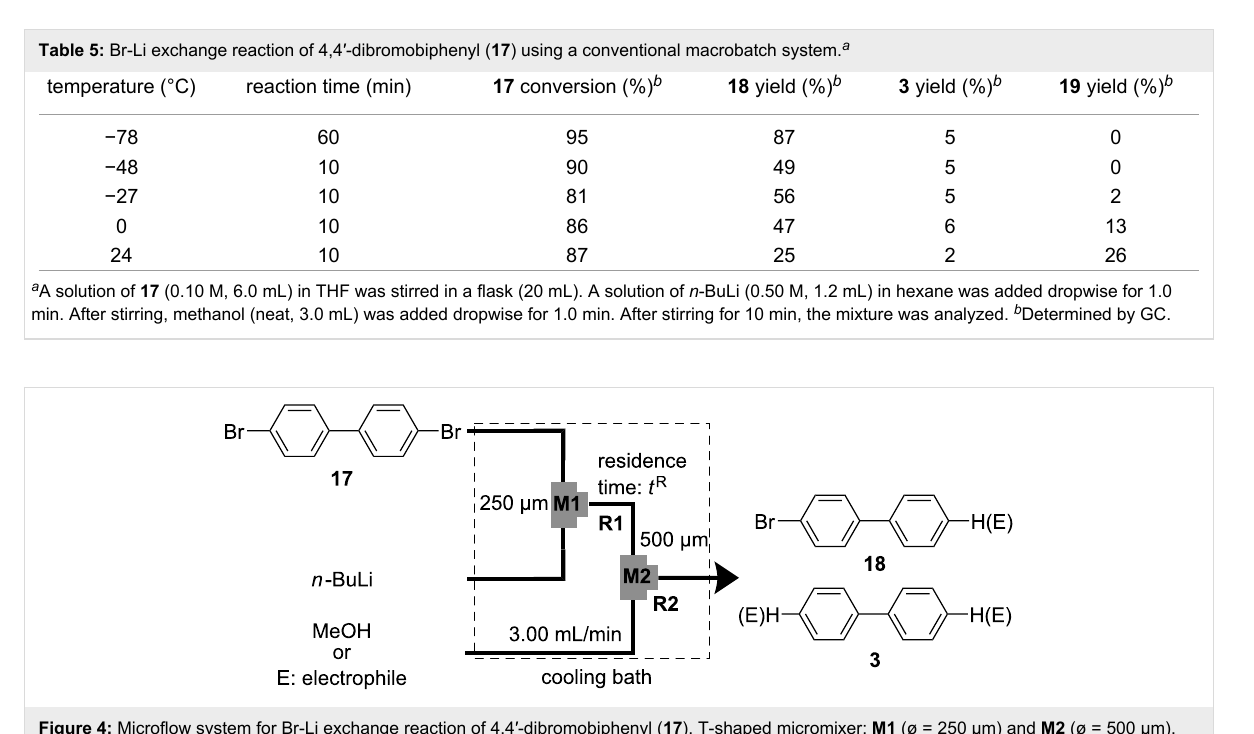
Figure 4: Microflow system for Br-Li exchange reaction of 4,4′-dibromobiphenyl ( 17 ). T-shaped micromixer: M1 (ø = 250 μm) and M2 (ø = 500 μm), microtube reactor: R1 and R2 (ø = 1000 μm, l = 50 cm), a solution of 4,4′-dibromobiphenyl ( 17 ): 0.10 M in THF, a solution of n -BuLi: 0.50 M in hexane, a solution of an electrophile: 0.30 M in THF.